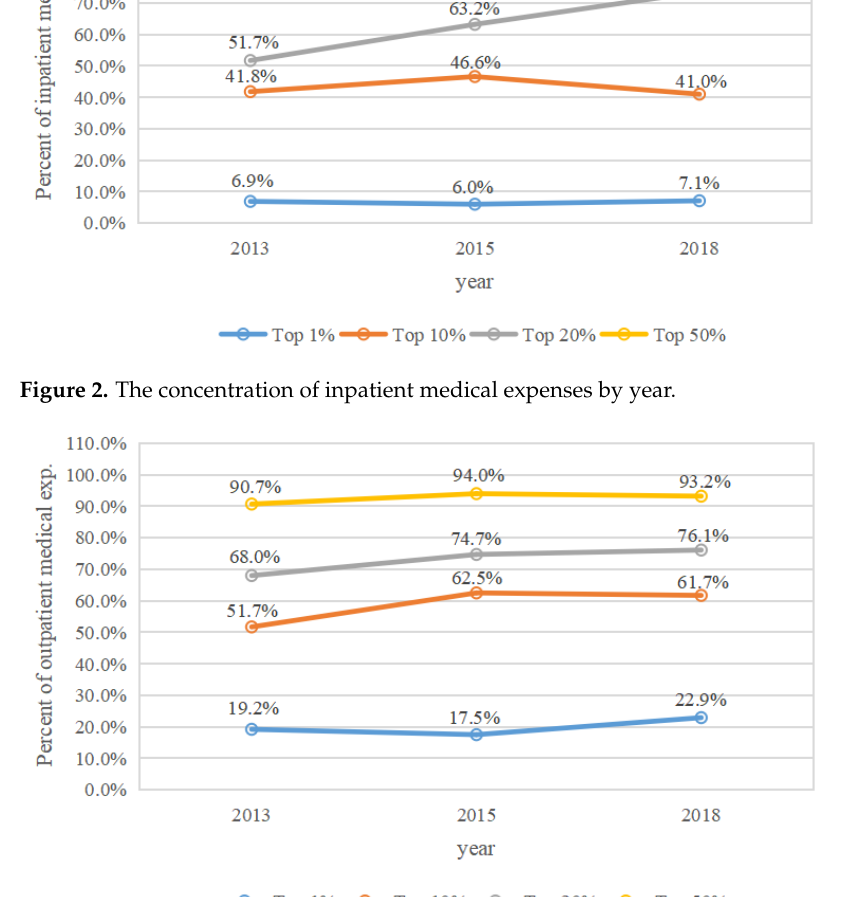
Figure 2. The concentration of inpatient medical expenses by year.